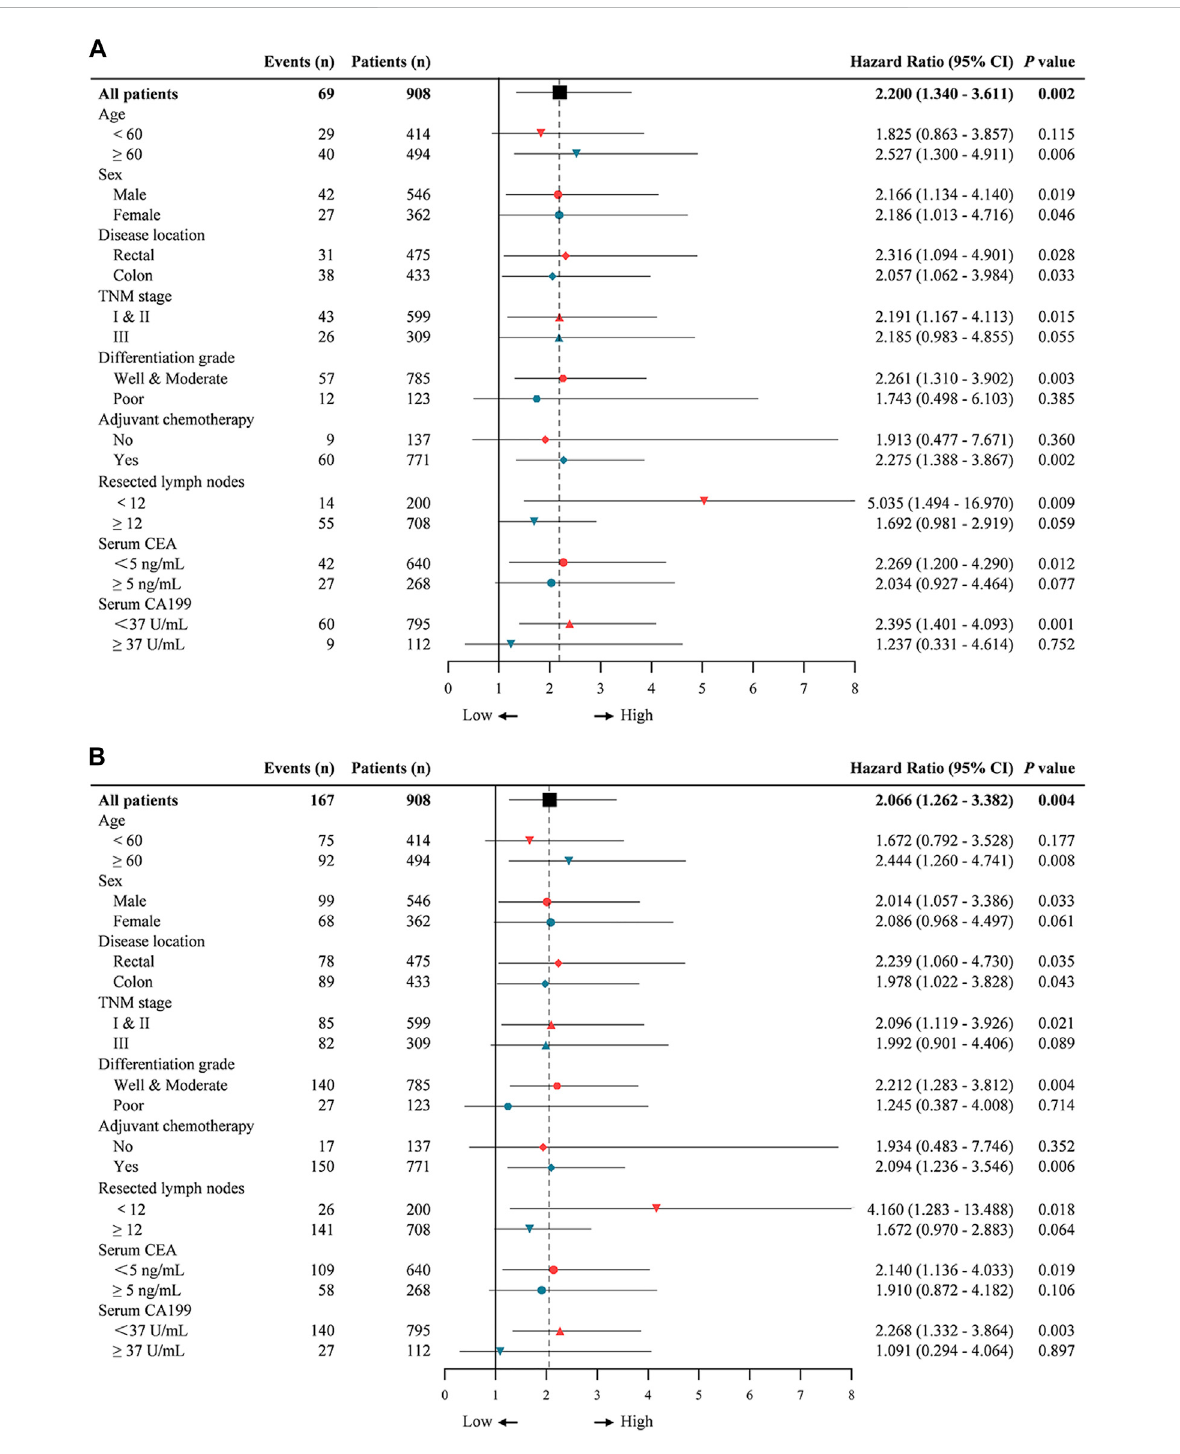
FIGURE 3 Univariable subgroup analyses of overall survival (A) and disease-free survival (B) in CRC patients. The dotted line shows the hazard ratio for all